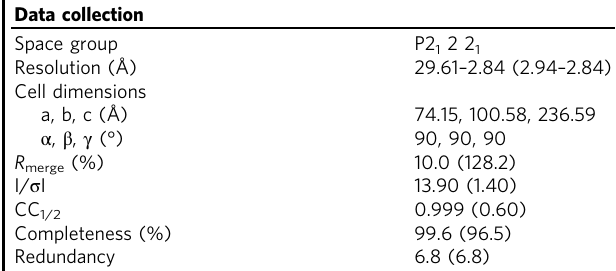
Table 1 X-ray crystallography data collection and